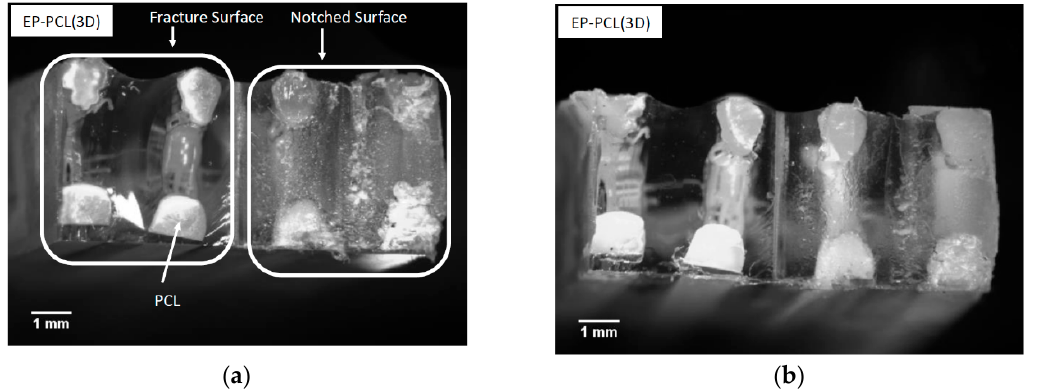
Figure 8. Optical microscope images of the fracture surface of an EP-PCL(3D) specimen tested under impact conditions. ( a ) Before healing and ( b ) after healing.